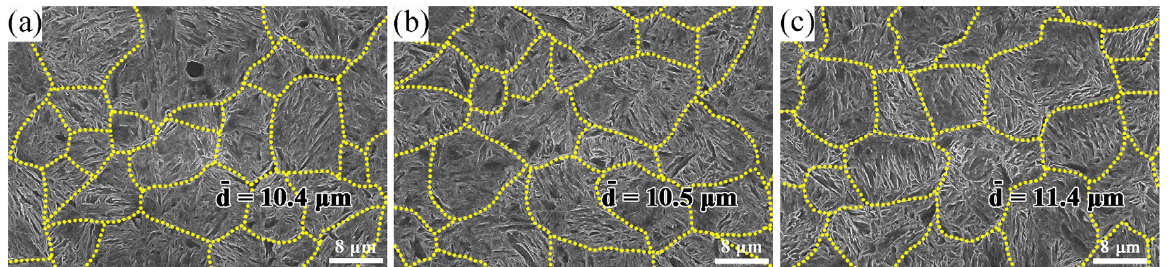
Figure 4. The prior austenite grain size at different quenching temperatures ( a ) 860 °C; ( b ) 880 °C; ( c ) 900 °C.